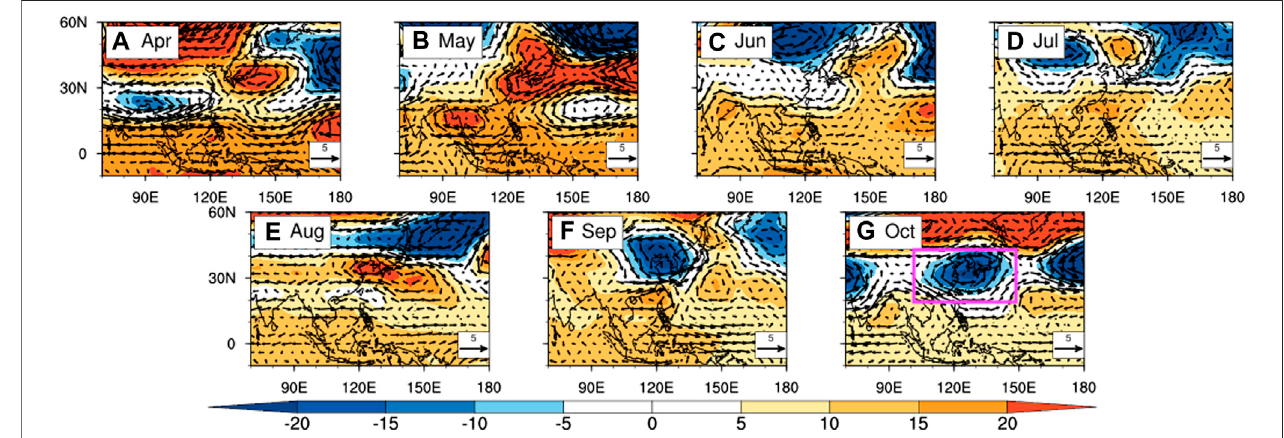
FIGURE 12 | Composite differences of (A) April, (B) May, (C) June, (D) July, (E) August, (F) September, and (G) October mean 500-hPa geopotential height (shading;unit:gpm)and500-hPawindanomalies(vector;unit: m s − 1 )betweentheextremehighandlowyearsofU500 BOB,4 .Pinkrectanglein (G) indicatesthecyclonic anomaly in positive U500 BOB,4 which is not favorable for TC landfalls on South China.